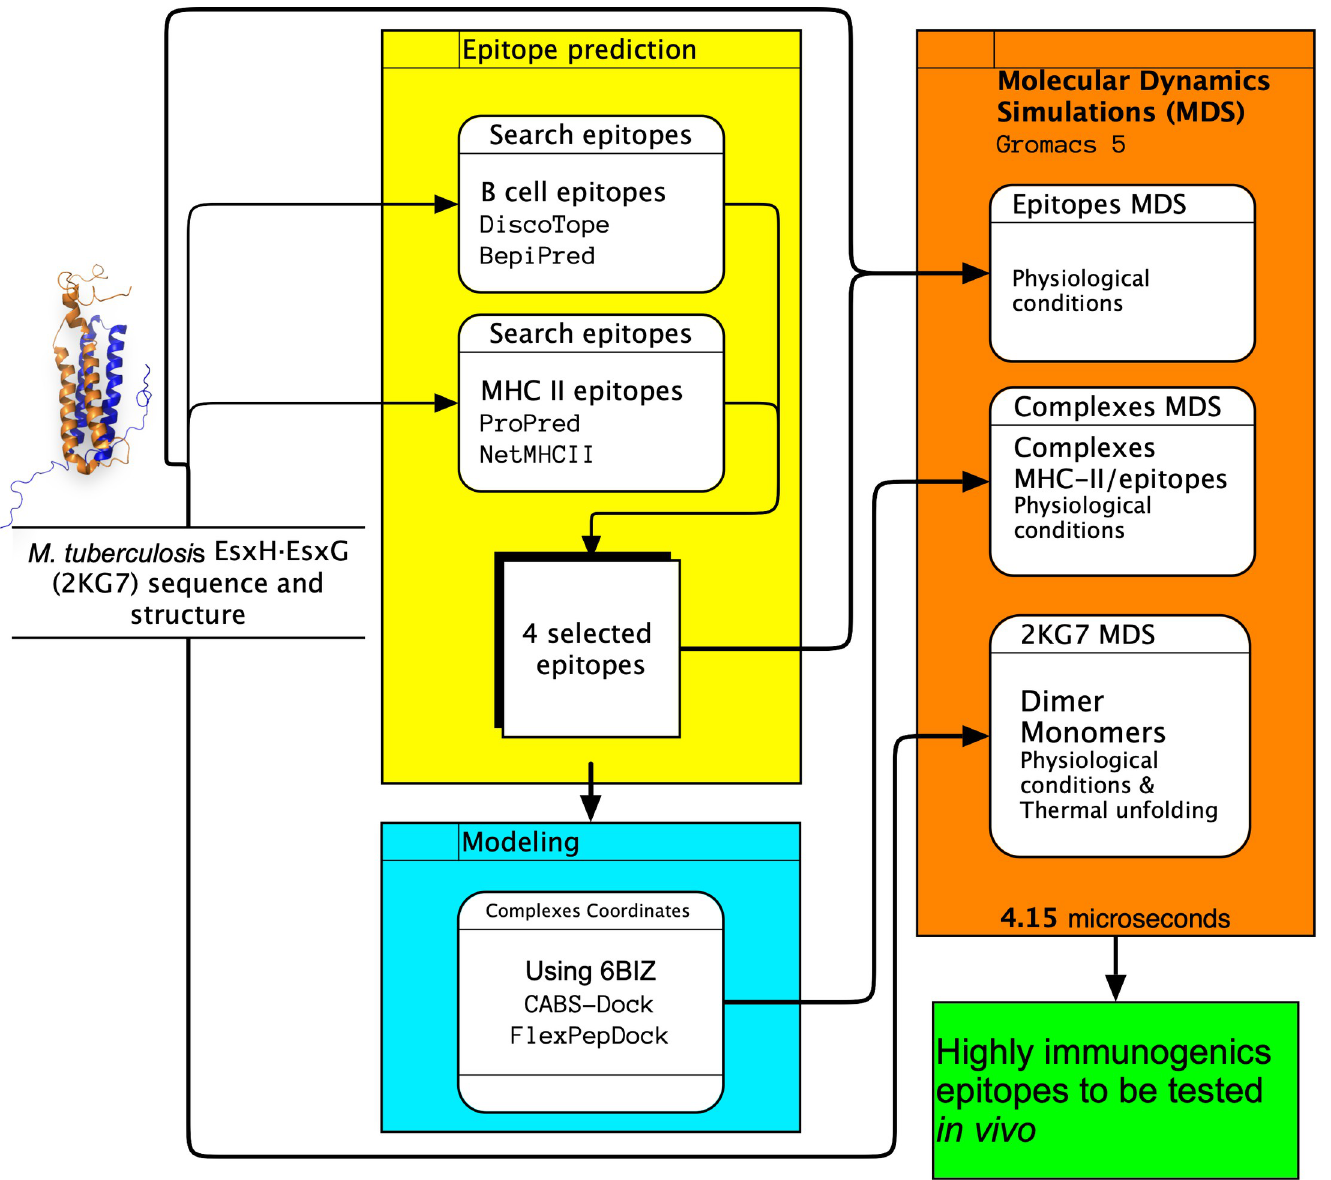
Fig 1. Summary fig. It shows all the steps that were applied in this work for the rational vaccine design to get highly immunogenic epitopes from EsxG and EsxH mycobacterial proteins. These are efficiently recognized by MHC-II and induce antibodies production using bioinformatics tools and Molecular Dynamics